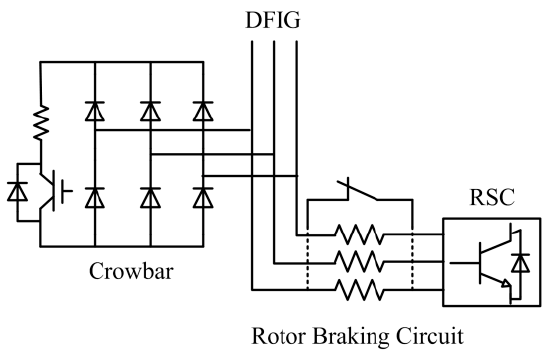
Figure 3. Configuration of the proposed protection.